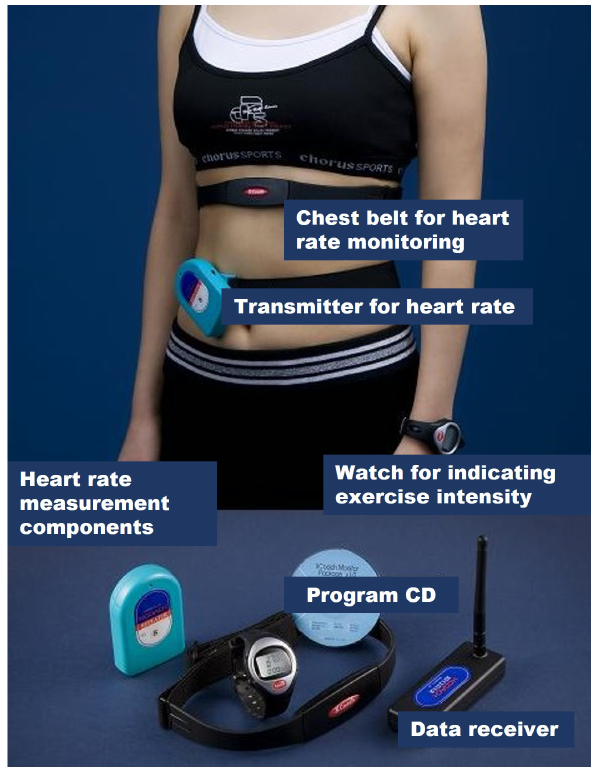
Fig. 2. Device for checking a heart